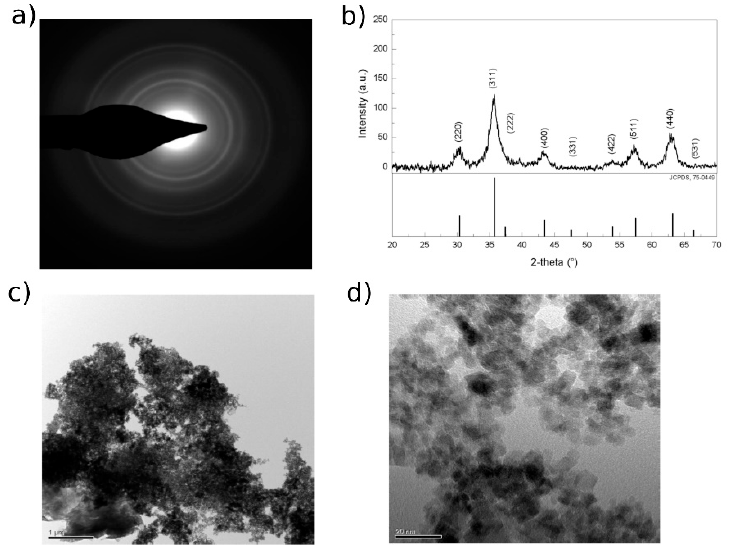
Figure 2. MA ( a ) TEM diffraction pattern. ( b ) Diffraction pattern collected with XRD apparatus for succinic-coated magnetite nano-aggregates and XRD reference pattern of Fe 3 O 4 from the Joint Committee on Powder Diffraction Standards (JCPDS), no. 75-0449. ( c , d ) TEM images. Scale bars: 1 μ m ( c ), 20 nm ( d ).